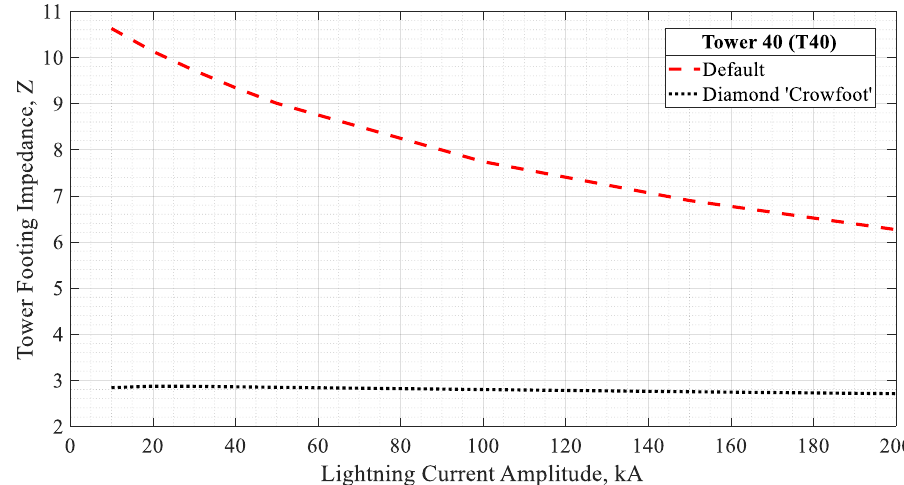
Figure 14. Variation of lightning current amplitude for Tower T40.